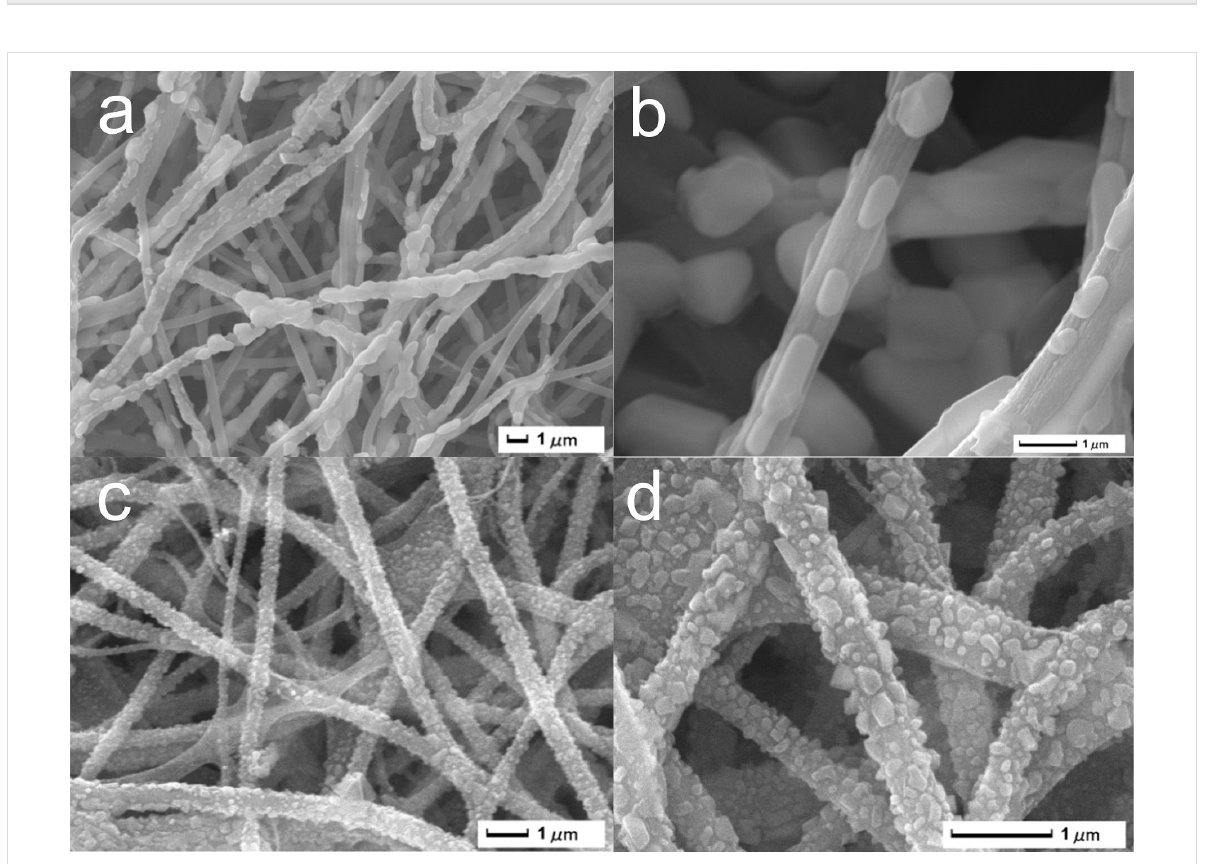
Figure 3: SEM pictures of LiFePO 4 and Li 4 Ti 5 O 12 nanofiber membranes. (a, b) LiFePO 4 ; (c, d) Li 4 Ti 5 O 12 .